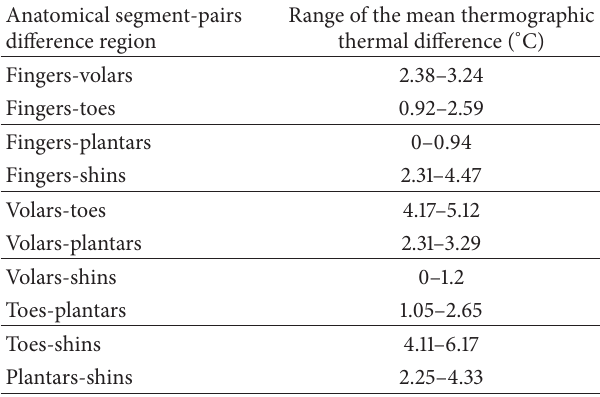
Table 1: Mean thermal difference and standard deviation between sets of measured regions corresponding to anatomical